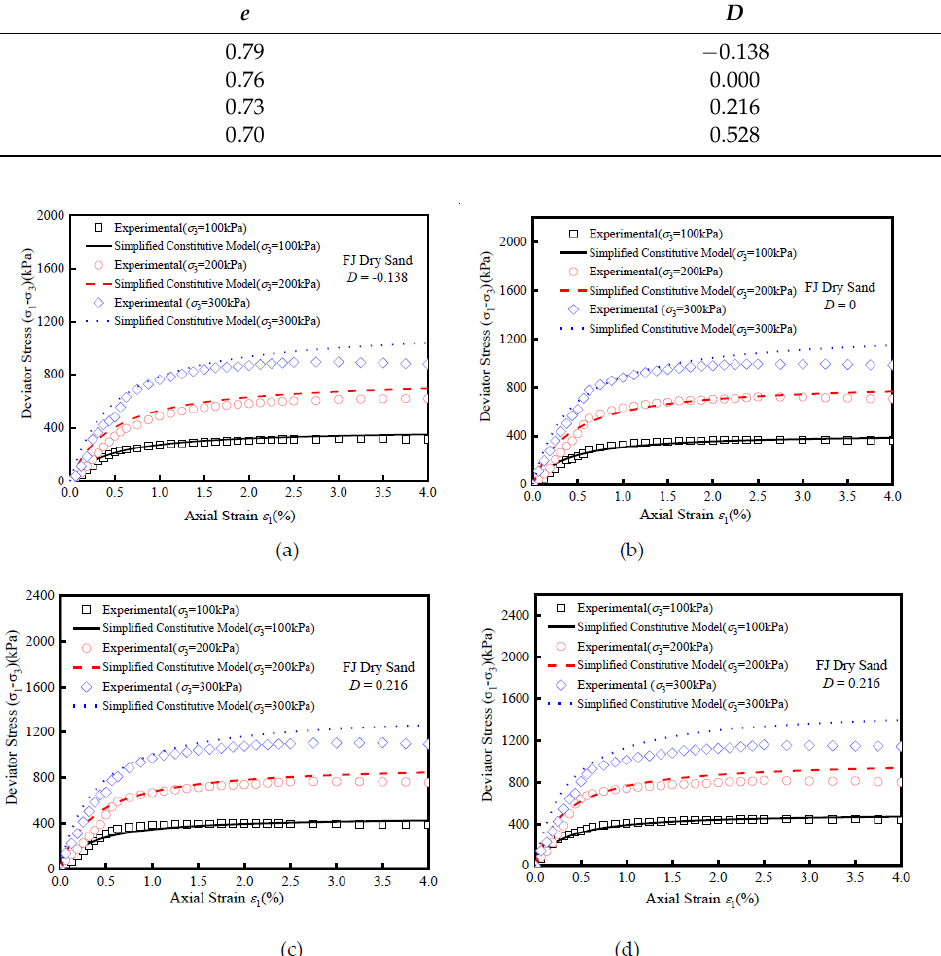
Table 7. Soil disturbance degree of the FJ dry sand.